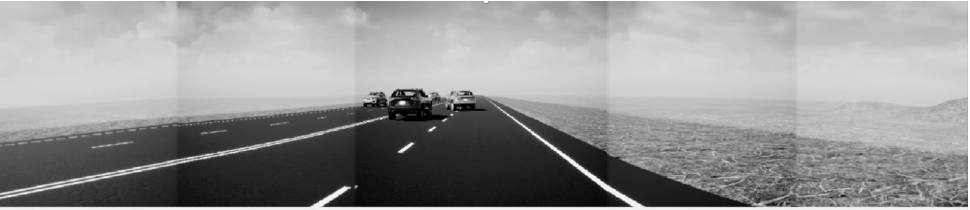
Figure 14. A screenshot showing a virtually generated panorama, as seen through simulated cameras, from the ego vehicle. Image is in gray-scale to reflect the output type of thermal images.